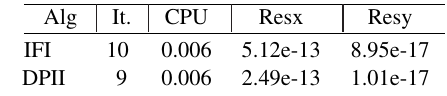
Table 1. Numerical results for Example